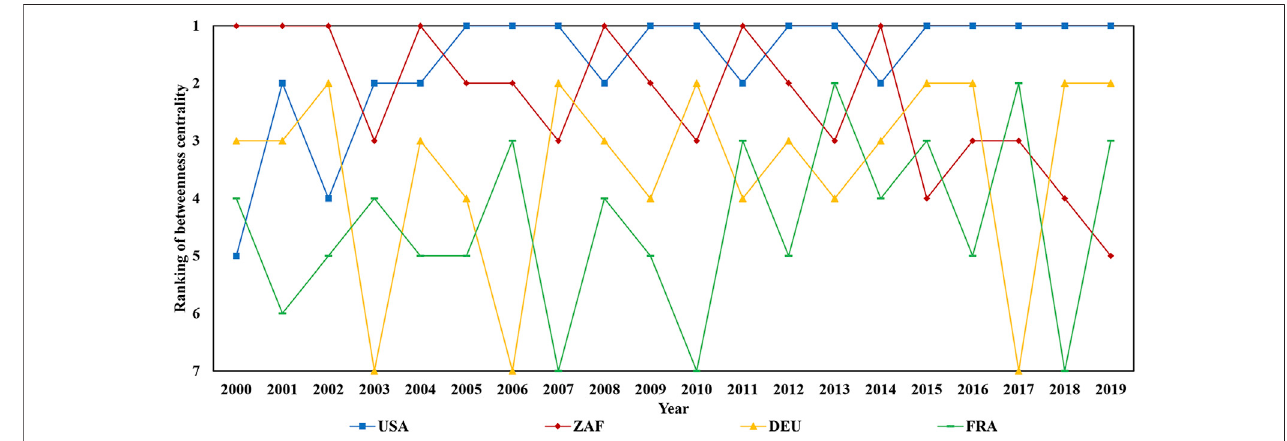
FIGURE 8 | The rankings of betweenness centrality from 2000 to